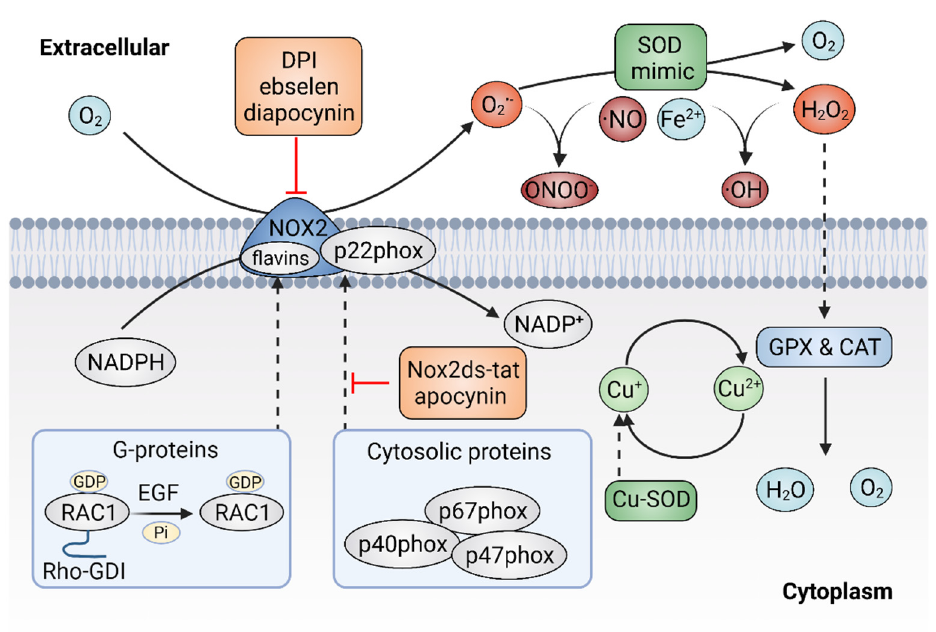
Figure 4. Targeting ROS with enzymatic antioxidants. The inhibitors of plasma membrane NADPH oxidase 2 (NOX2) can prevent the production of superoxide (O 2 •− ) and superoxide dismutase (SOD) mimics might dismutate O 2 •− to hydrogen peroxide (H 2 O 2 ). Table 1. Anticancer antioxidants in clinical trials.